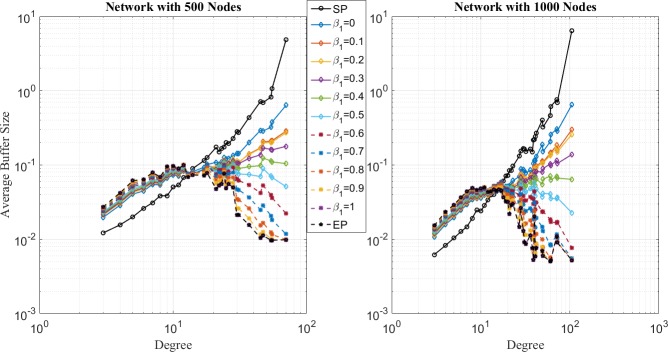
Relationship between average buffer size and node degree for different routing strategies on networks with 500 nodes (left figure) and 1000 nodes (right figure) in low traffic case.